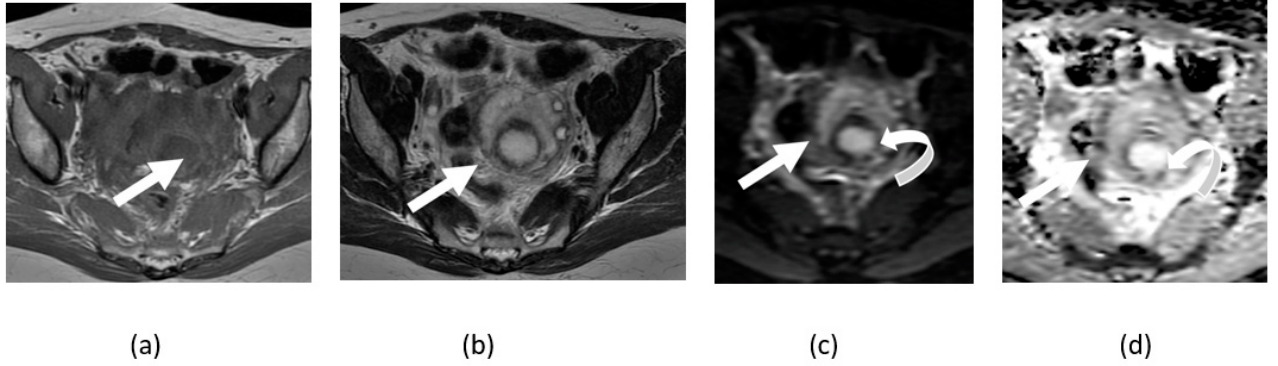
Figure 6. Axial T1- ( a ) and T2-weighted ( b ) images showing heterogeneous left adnexal twisted structure (arrows) with surrounding rim, which shows faint rim of subtle diffusion restriction (curved arrows) on corresponding axial DWI ( c ) and ADP maps ( d ).